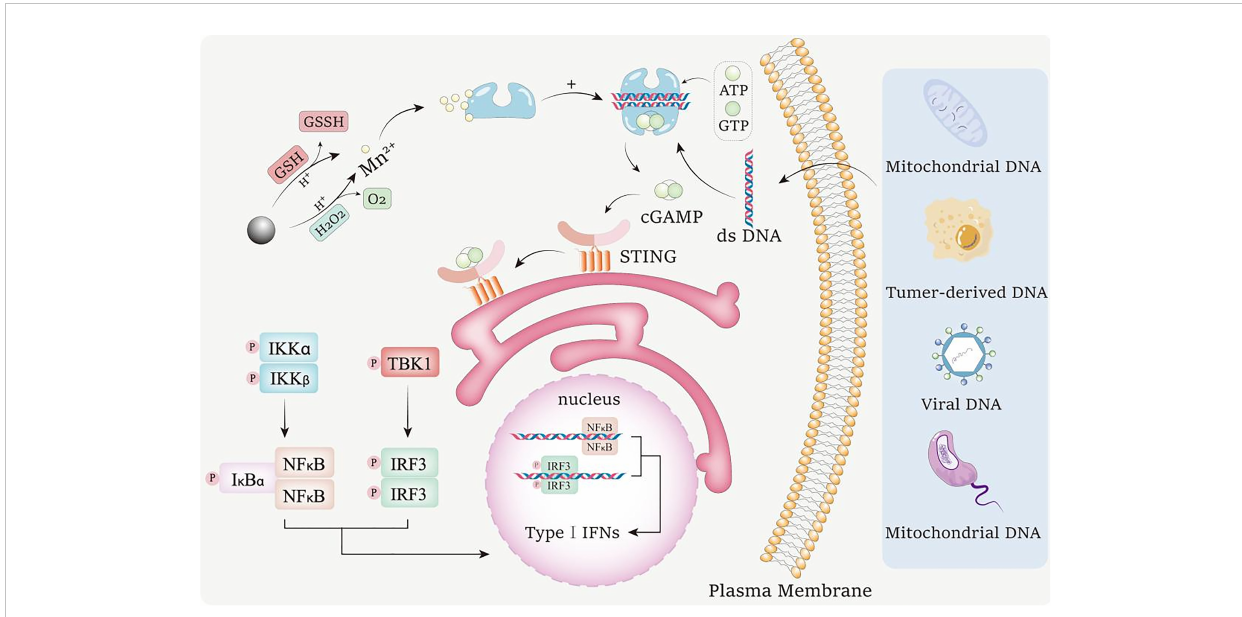
FIGURE 2 Mechanism for the conversion of MnO 2 nanomaterials into Mn 2+ to activate cGAS-STING pathway. MnO 2 nanomaterials can undergo redox reactions with GSH and H 2 O 2 in acidic tumor environments to consume excessive GSH and H 2 O 2 in tumor environments. In response, Mn 2+ is released, and the generated O 2 can improve the tumor hypoxia state. Mn 2+ enhances the ability of cGAS to recognize dsDNA from bacteria, tumor cells, viruses and mitochondria in the environment, and promotes the production of 2 ’ ,3 ’ - cyclic GMP AMP (2 ’ ,3 ’ - cGAMP). cGAMP binds to interferon gene stimulator (STING), resulting in tank binding kinase 1 (TBK1) dependent phosphorylation (P) of interferon regulator 3 (IRF3). The active IRF3 dimer transfers to the nucleus and activates the transcription of type I interferon gene. STING can also activate I k B kinase (IKK), phosphorylated NF- k B Inhibitory Protein I k B a , Lead to polyubiquitination and degradation, and then NF- k B can enter the nucleus and start the transcription of immune stimulating